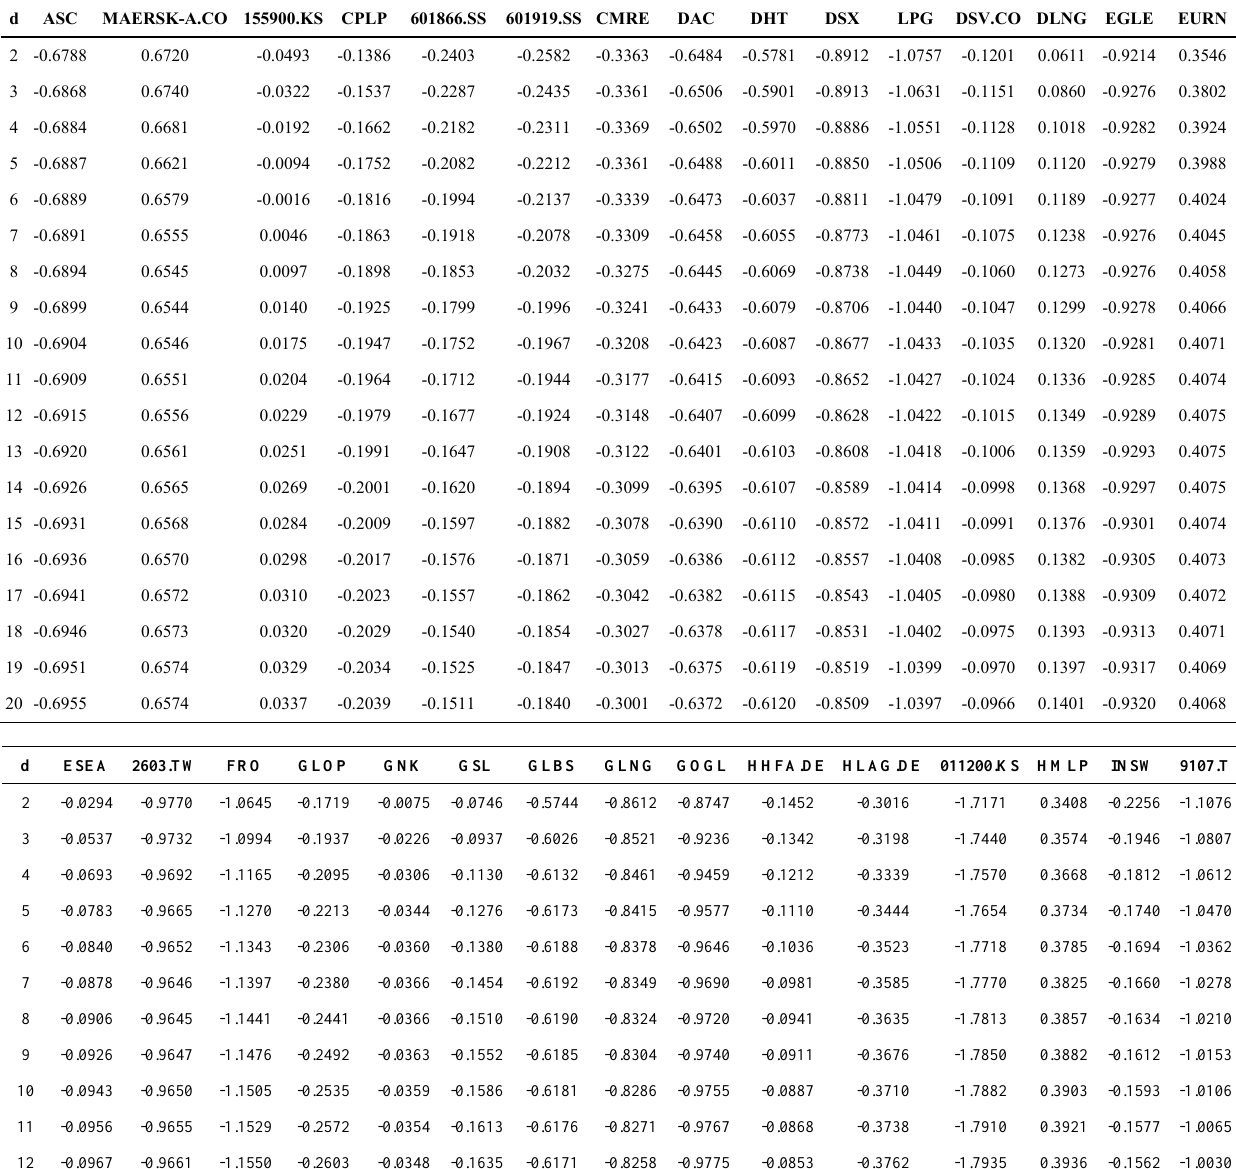
Table 4. The net values of Rényi entropy for equities listed in Table